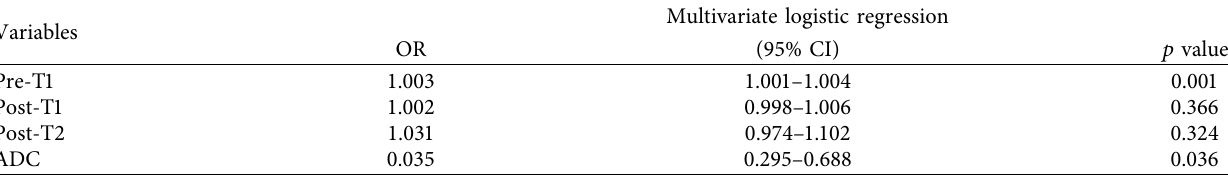
Table 4: Multivariate logistic regression analysis of variables associated with Ki-67